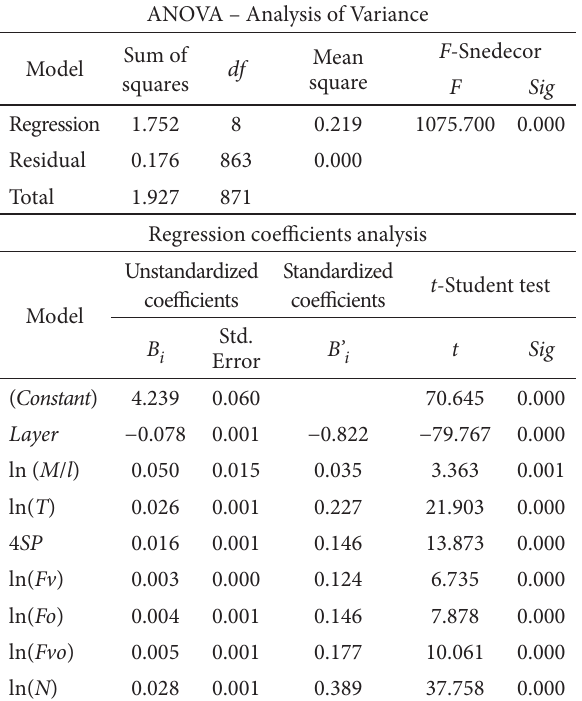
table 7. PQI data regression